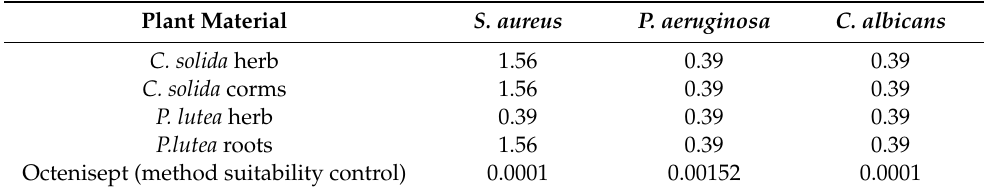
(Table 3). Root extract of the species as well as both extracts of C. solida exhibited weaker activity against S. aureus (MIC at 1.56 mg / L) than against other tested strains (MIC at 0.39 mg / L) (Table 3). Table 3. Minimum Inhibitory Concentration (MIC) [mg / L] of water–methanolic extracts from S. solida and P. lutea herb and underground